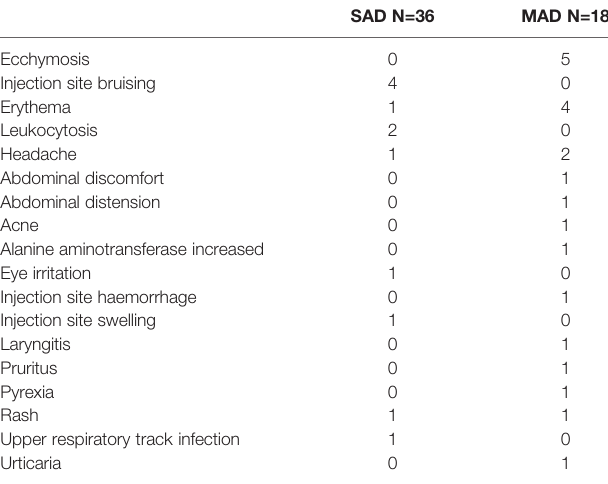
TABLE 1 | Treatment-emergent adverse events in AMG 966 treated subjects.